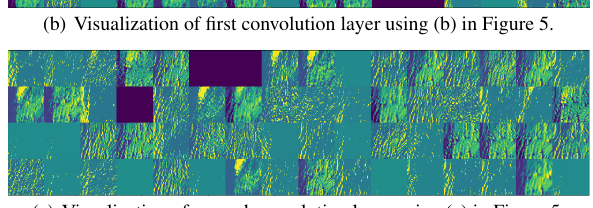
(b) Visualization of first convolution layer using (b) in Figure 5.